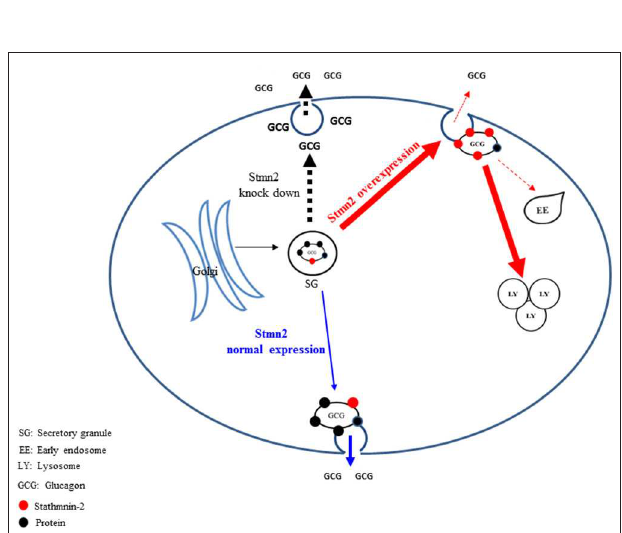
FIGURE 6 | marker LAMP2A. Images were acquired and analyzed for co-localization as described in Figure 1 . (A) In wt cells, glucagon and LAMP2 show some co-localization at the plasma membrane (arrowheads). (B) In cells overexpressing Stmn2, there is colocalization of glucagon and LAMP2A in the cell body (arrowheads) and at the plasma membrane (arrows). (C) In cells in which Stmn2 levels are depleted, there is almost no detectable co-localization of glucagon and LAMP2A. (D) Level of colocalization between glucagon and LAMP2A was determined by Pearson’s correlation coefficient in wt cells, cells in which Stmn2 was overexpressed (OE) and in which Stmn2 was knocked down by siRNA (KD). (E) Fluorescence intensity of Lamp2A in wt cells, and following overexpression (Stmn2-OE) or knockdown (Stmn2-KD) of Stmn2. Values are expressed as mean ± SD and compared by 1-Way ANOVA. * p < 0.01; ** < 0.001 compared to wt.